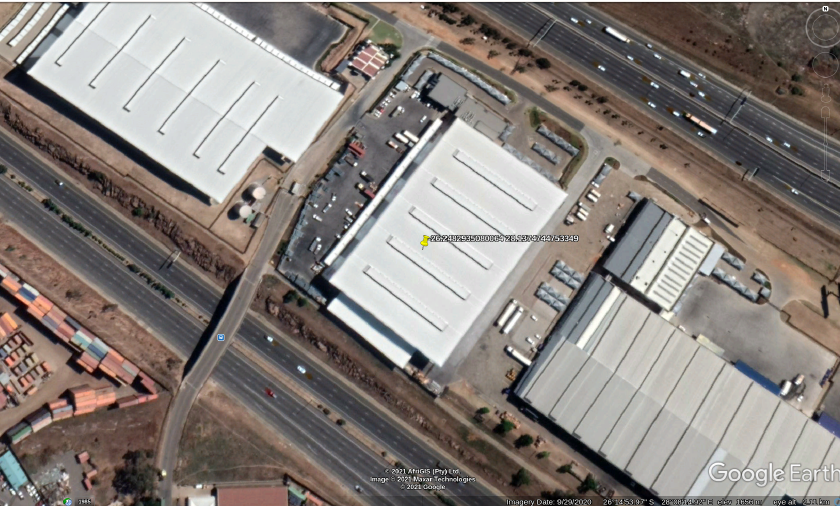
Figure 16. Google Earth image of a factory yard in Alberton.